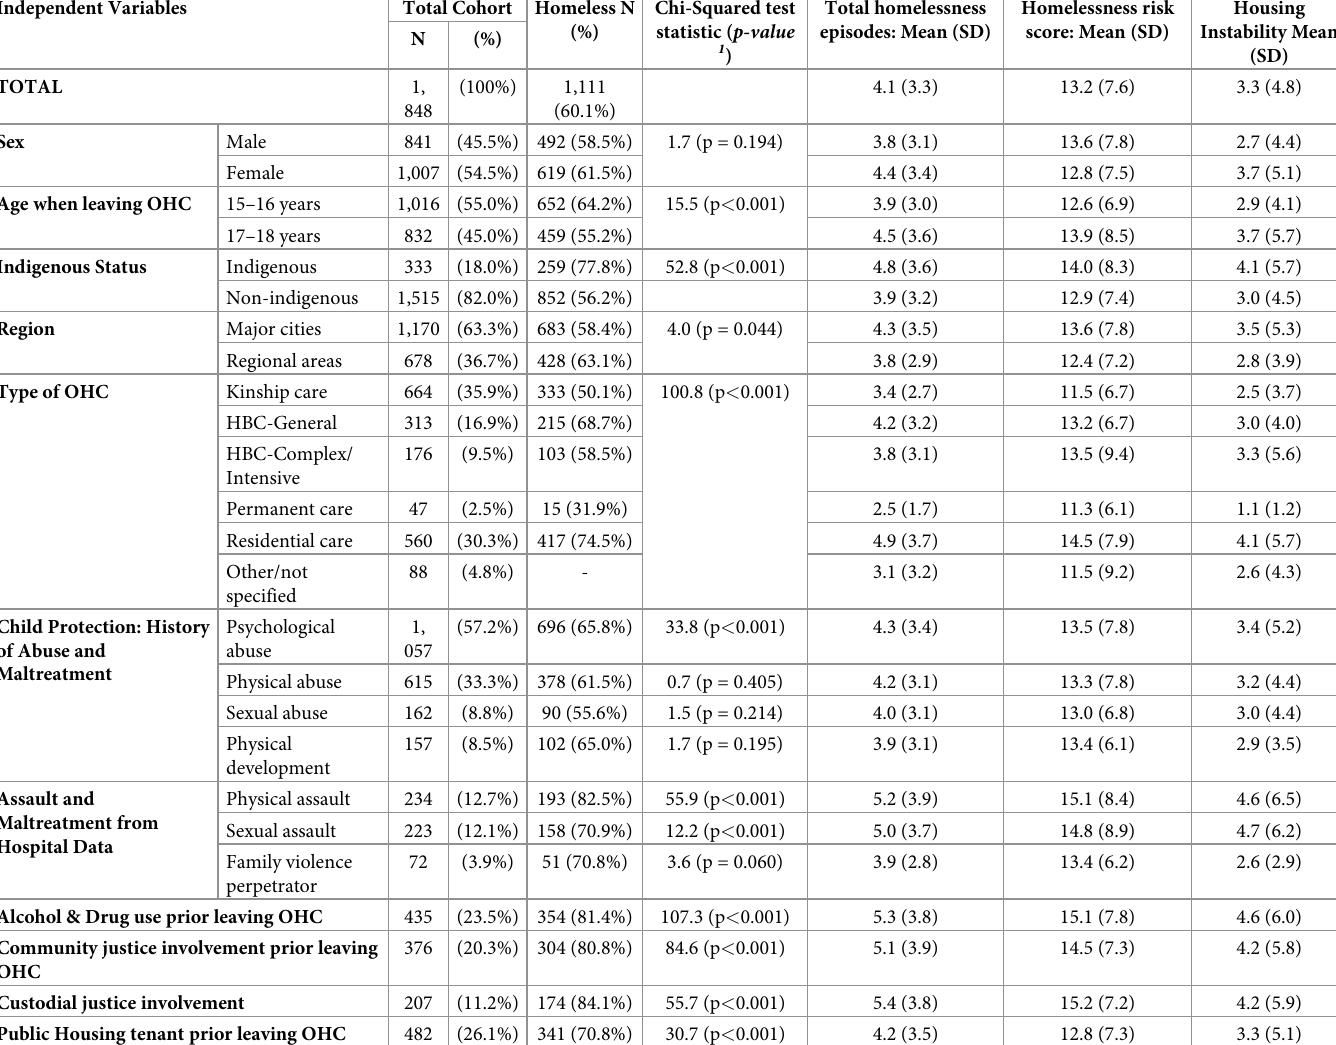
Table 2. Demographic and background characteristics for total cohort, homelessness and housing instability summaries and risk scores. Independent Variables Total Cohort Homeless N